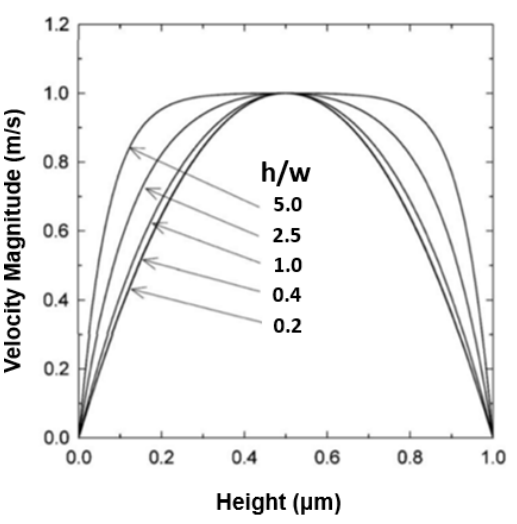
Figure 11. The variations of the velocity profile for different values of the aspect ratio of height (h) and width (w).